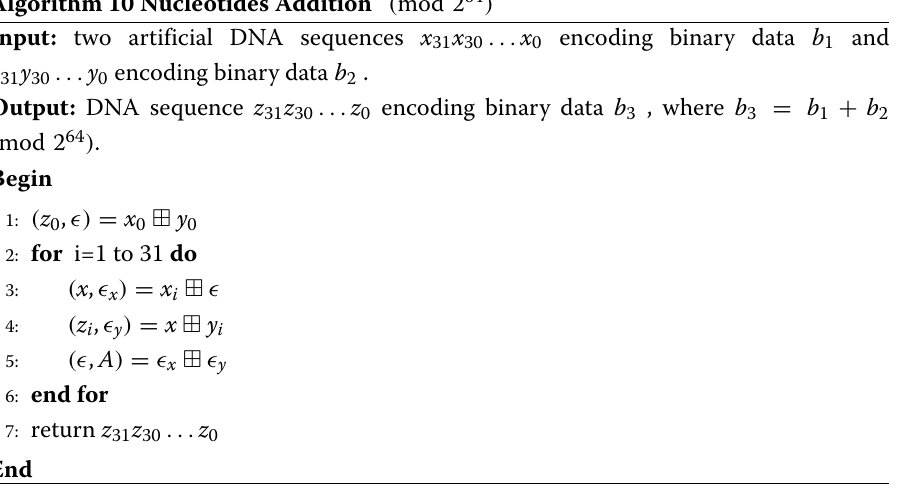
Algorithm 10 Nucleotides Addition ( mod 2 64 )